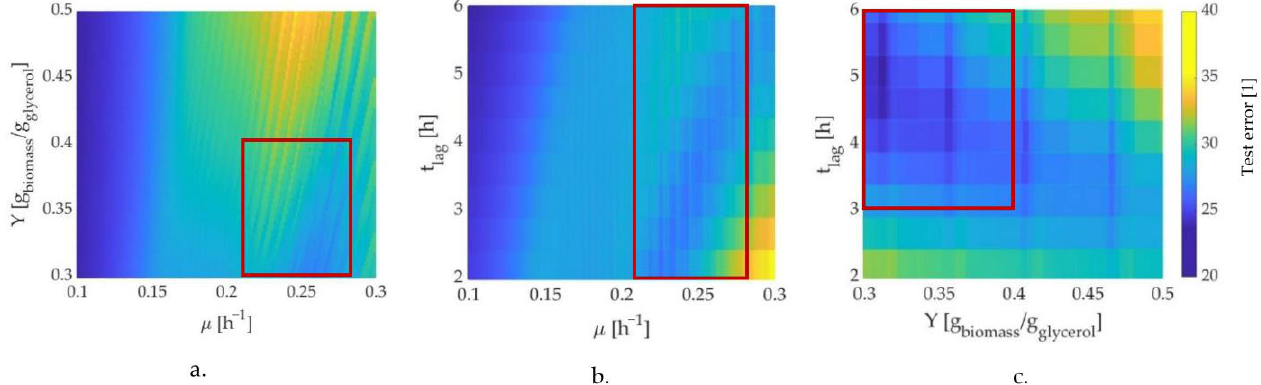
Figure 3. Search space for the parameters for the mathematical process model of H. polymorpha cultivation where: ( a ) t lag was held constant at 4.6 h, ( b ) Y was held constant at 0.34 g biomass /g glycerol , and ( c ) µ was held constant at 0.27 h − 1 . The red rectangles are showing the possible optimum regions with a range of 0.21 – 0.28 h −1 for growth rate ( µ ), 0.30 – 0.40 g biomass /g glycerol for yield factor ( Y ) and 3 – 6 h for lag time ( t lag ).